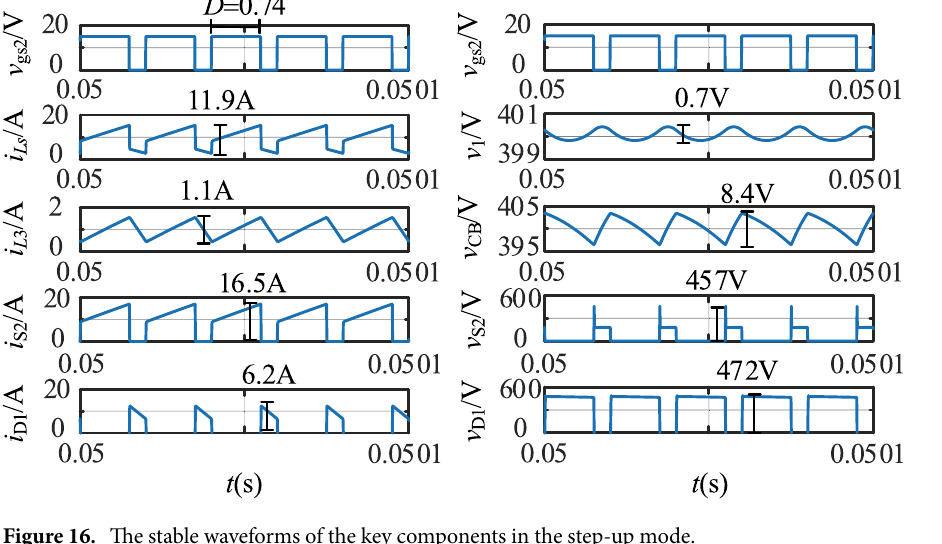
Figure 16. The stable waveforms of the key components in the step-up